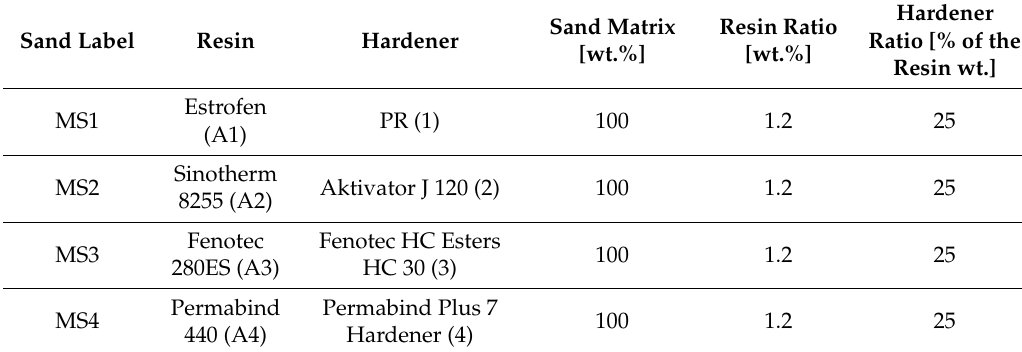
Table 1. Molding sand mixtures for the alkali-phenolic process.